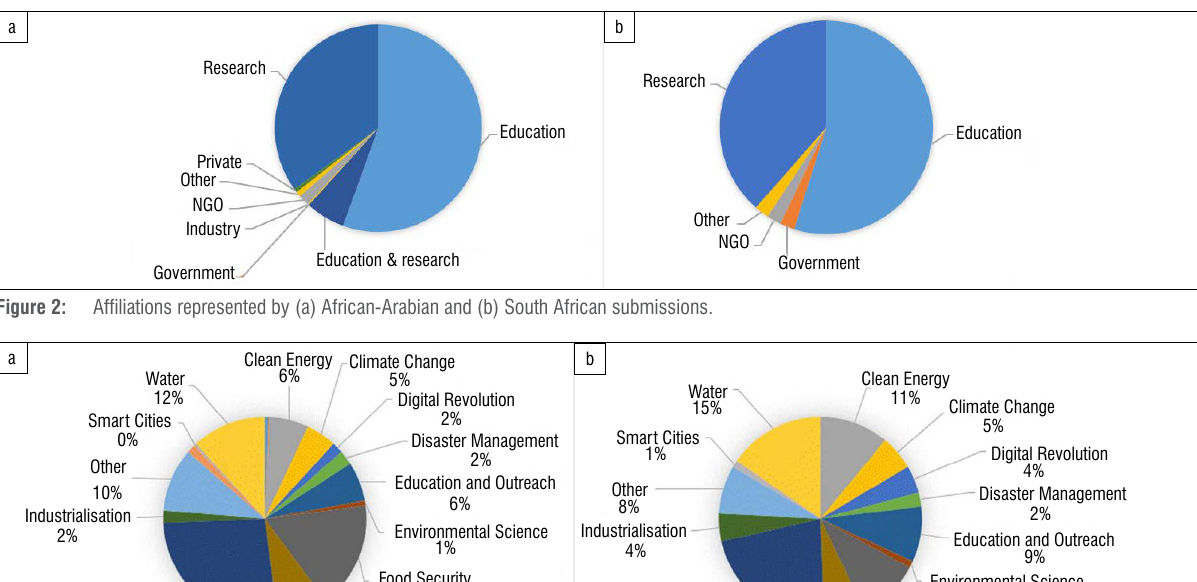
Figure 1: Descriptive statistics of all African-Arabian submissions including South Africa (SA): (a) gender, (b) number of authors, (c) qualification and (d) age.